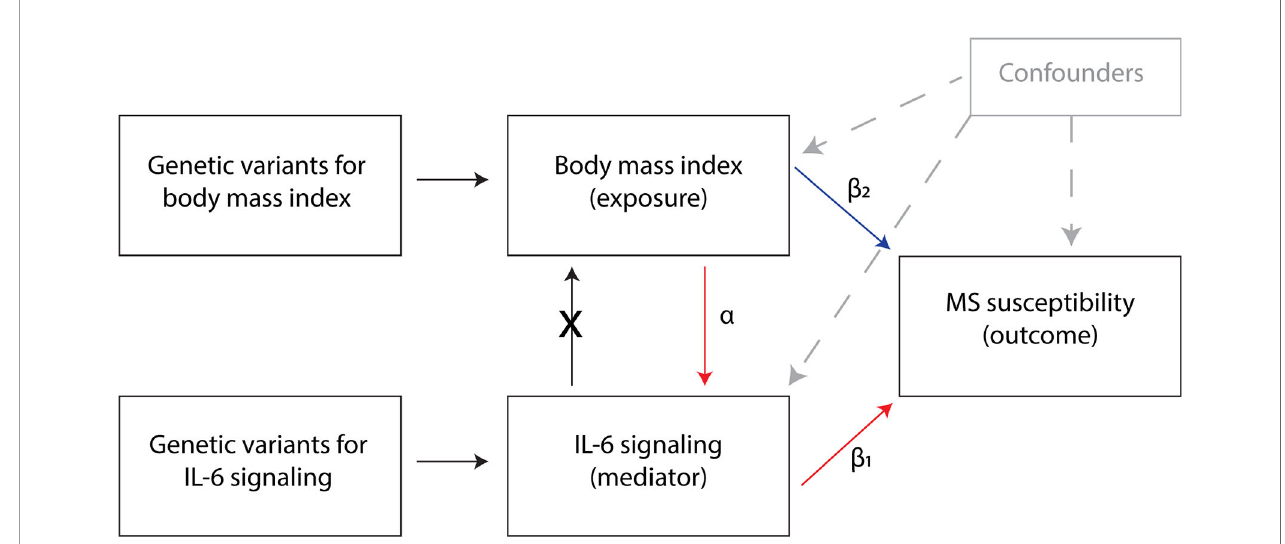
FIGURE 1 | Directed acyclic graph of the Mendelian randomization mediation analysis. a = the effect of BMI on IL-6 signaling levels; b 1 = the effect of IL-6 signaling on MS, adjusted for BMI using multivariable MR; b 2 = the effect of BMI on MS, independently from IL-6 signaling; the indirect effect is estimated by multiplying a with b 1. The proportion mediated is estimated by dividing the indirect effect ( a * b 1 ) by the total effect of BMI on